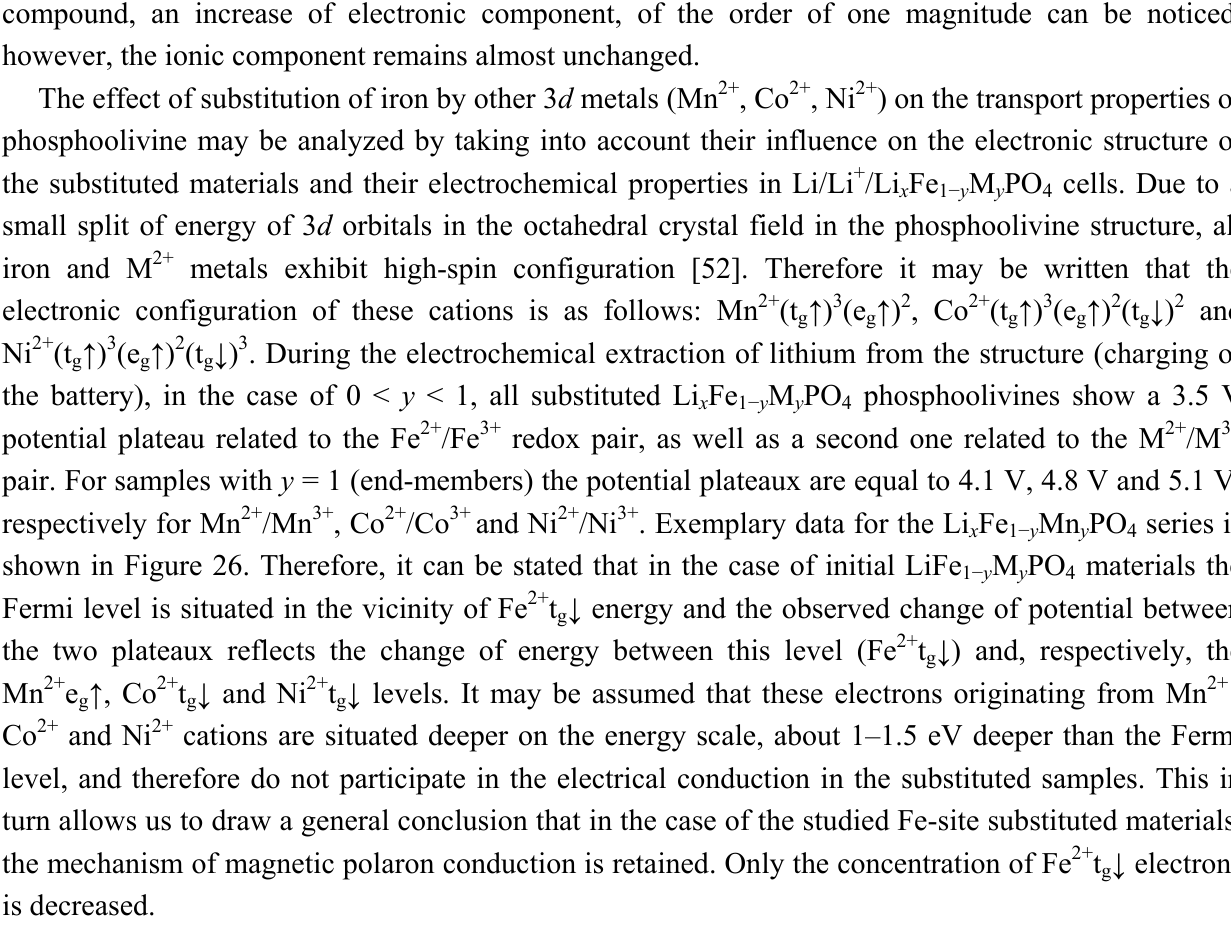
Figure 24. Temperature dependence of thermoelectric power of LiFe